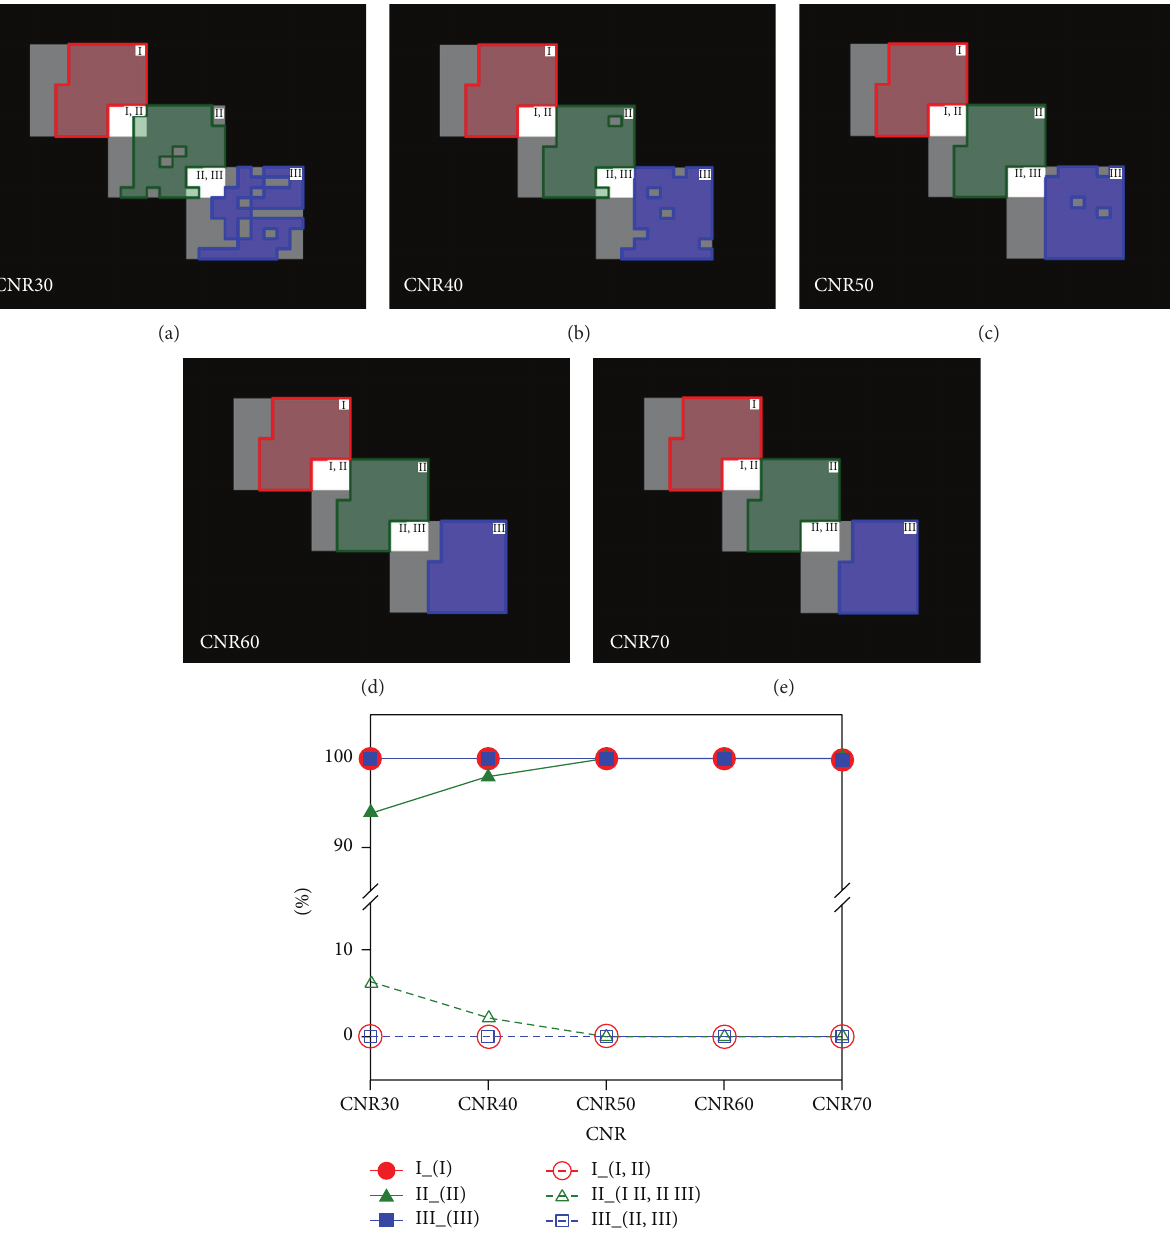
Figure 2: The performance of signal segmentation for three ROIs after ICA. The spatial segmentation of ROIs was listed in (a)–(e) along different CNRs. The area symbols for artery, surrounding tissue, and tissue are denoted as I, II, and III, respectively. The performance in signal segmentation is summarized in (f). The solid line denotes the true rate of selected region located in the ROI and the dash line is the false rate outside